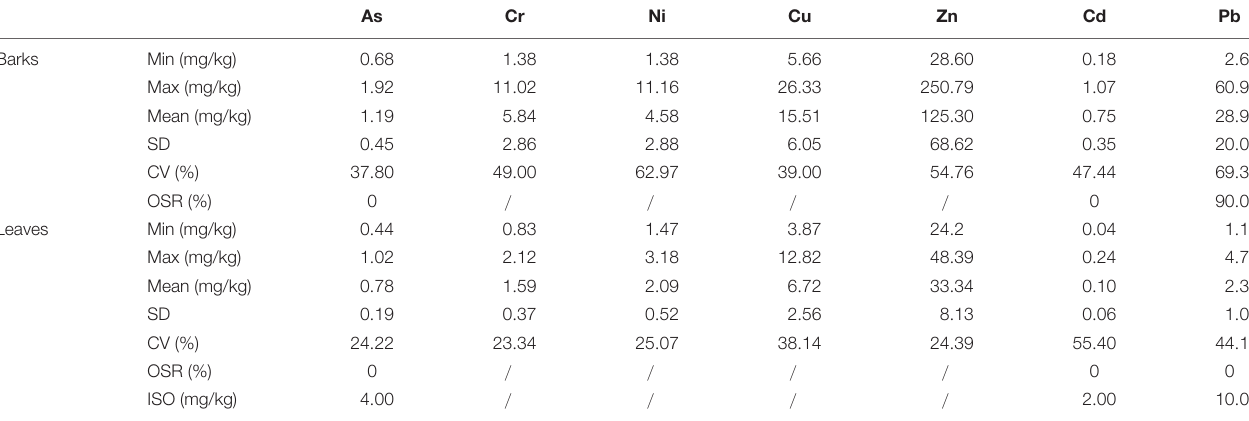
TABLE 1 | Heavy metal content in bark and leaves of the camphor